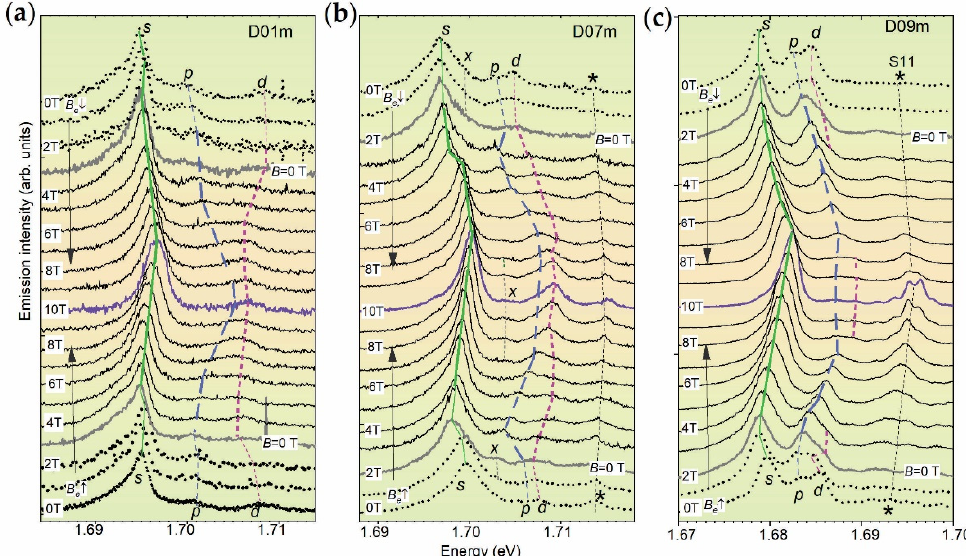
Figure 2. Low-temperature (10 K) magneto-PL spectra (thin solid curves) of D01m ( a ), D07m ( b ) and D09m ( c ) QDs measured in the field range B e = 0–10 T (thick solid curves are for B = 0 T, short-dot curves are for | B e | < | B ec |). Solid, dashed and short-dashed lines (thinner for | B e | < | B ec |) connecting the maxima of s -, p - and d -peaks, respectively, are drawn to outline their shift and bends; a star symbol denotes neighboring dot, which in ( c ) is the single electron dot S11 studied in Ref. [15]. Vertical arrows at the left show direction of field